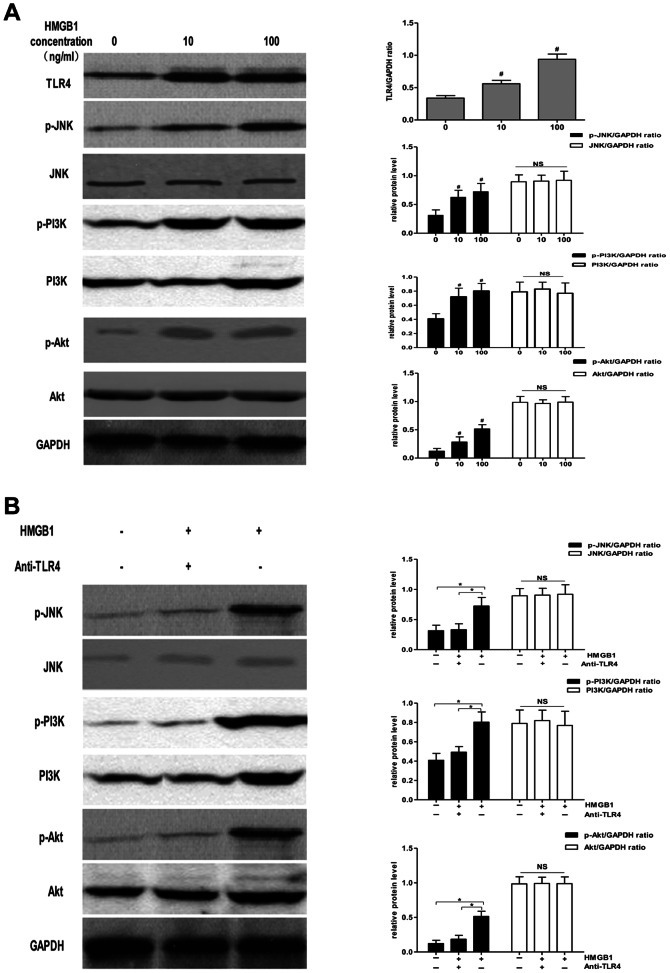
HMGB1 induced the activation of JNK and PI3K/Akt through TLR4.(A) Representative of significantly elevated expressions of both TLR4 and active forms of JNK, PI3K/Akt (p-JNK, p-PI3K and p-Akt) in response to HMGB1 stimulation at different concentrations. However no change of JNK, PI3K, and Akt were detected. Relative quantification of the active and total forms of JNK, PI3K, and Akt proteins are presented in the right panel. #p<0.05, compared with 0 ng/ml HMGB1; NS, not significant. (B) After pretreated with TLR4 neutralizing antibody (10 µg/mL) for 1 h, HSCs were cocultured with HMGB1 (100 ng/ml) for 24 h and then HMGB1-enhanced expression of p-JNK, p-PI3K and p-Akt were markedly decreased. Relative quantification of the active and total forms of JNK, PI3K, and Akt proteins are presented in the right panel. *p<0.05, compared with 100 ng/ml HMGB1; NS, not significant.